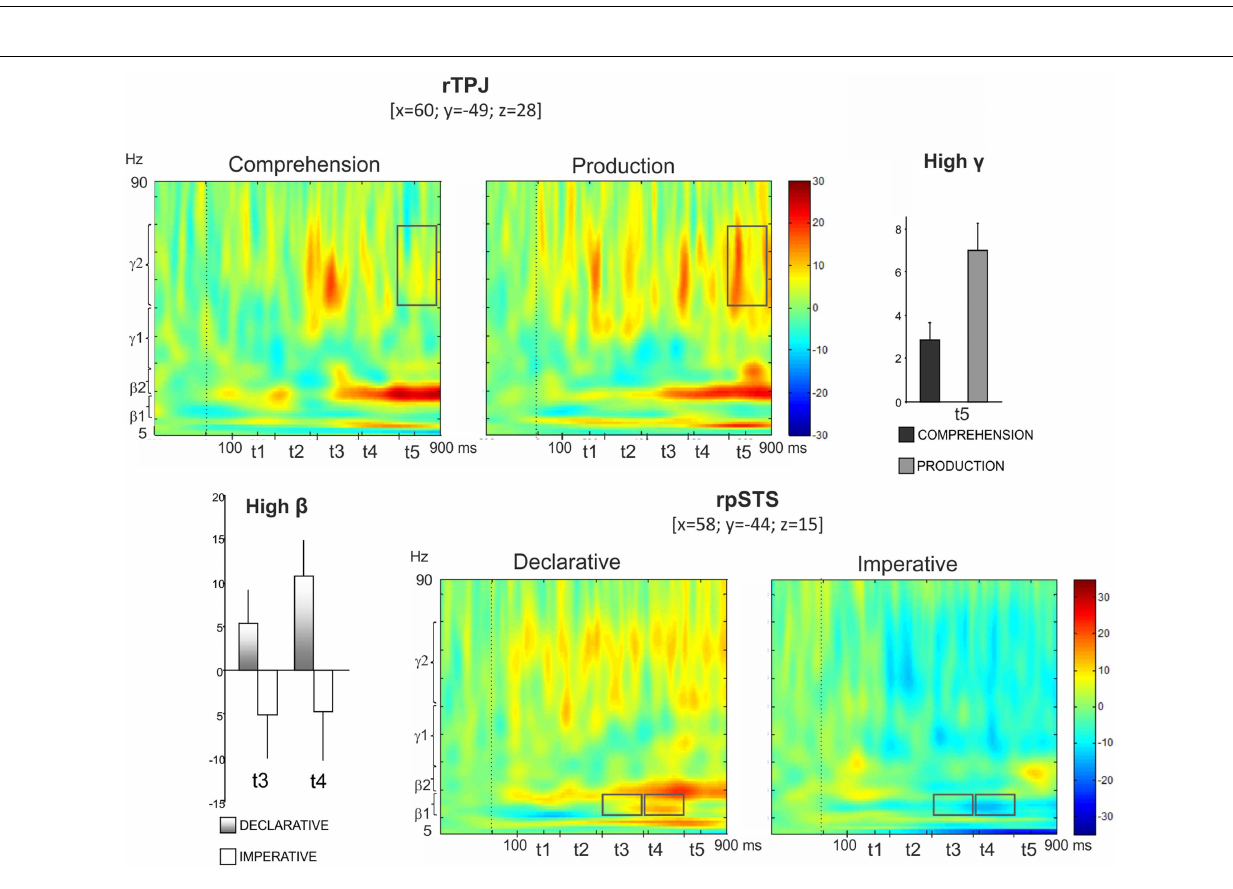
FIGURE 5 | Top : right temporo-parietal junction (rTPJ) . GroupTFRs during pointing comprehension and production: dotted line indicates the stimulus onset (left). In the frequency and time interval marked by superimposed gray boxes (740–900ms, high gamma), a time specific difference of power modulation between the production and the comprehension sessions was found. Bar plots show results for Bonferroni post hoc test: p < 0.01 (right).